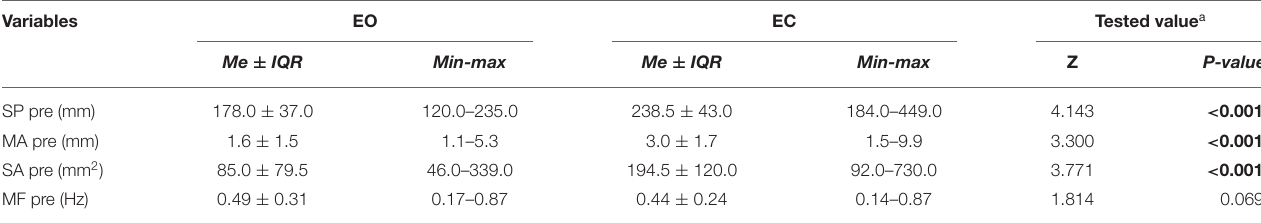
TABLE 1 | The descriptive statistics and differences in results of the pre-exposure postural stability tests with eyes open (EO) and eyes closed (EC).